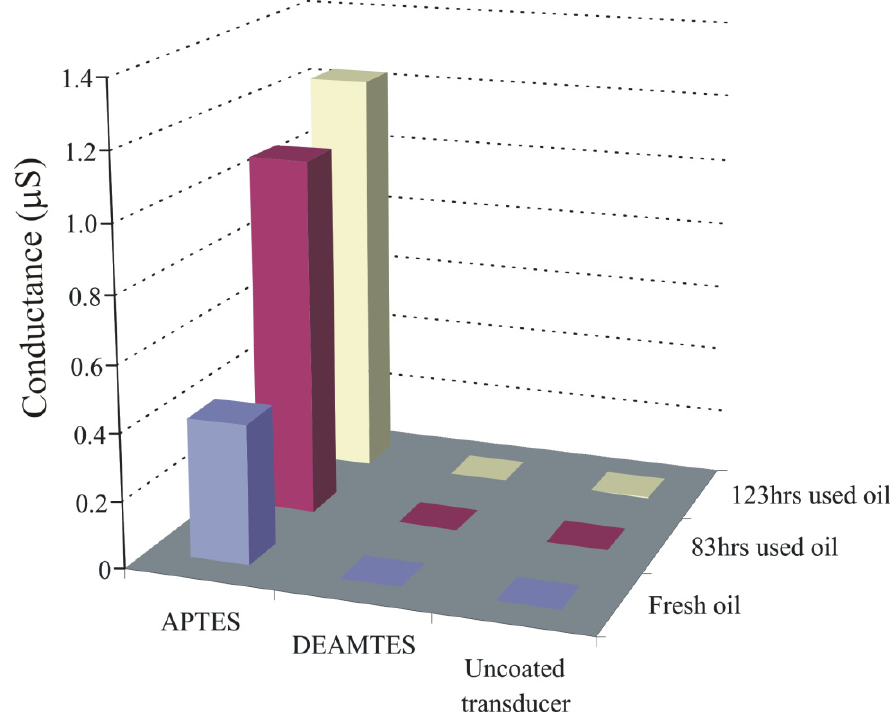
Figure 7. Assessing the quality of engine oil by conductometric sensors covered with DEAMTES, and APTES layers and compared with uncoated interdigital transducer